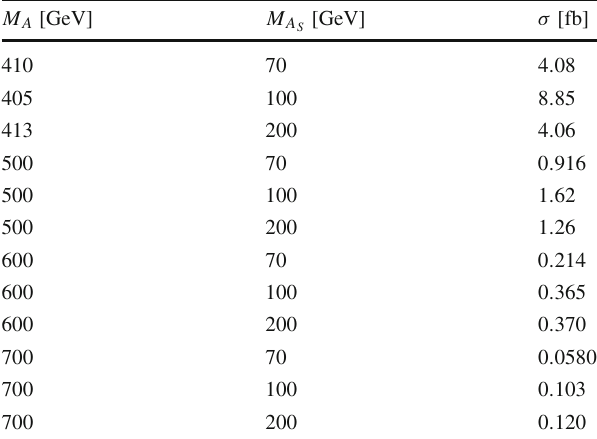
Table 2 Possible cross sections σ at 13 TeV for ggF → A → ( h → ττ) + ( A